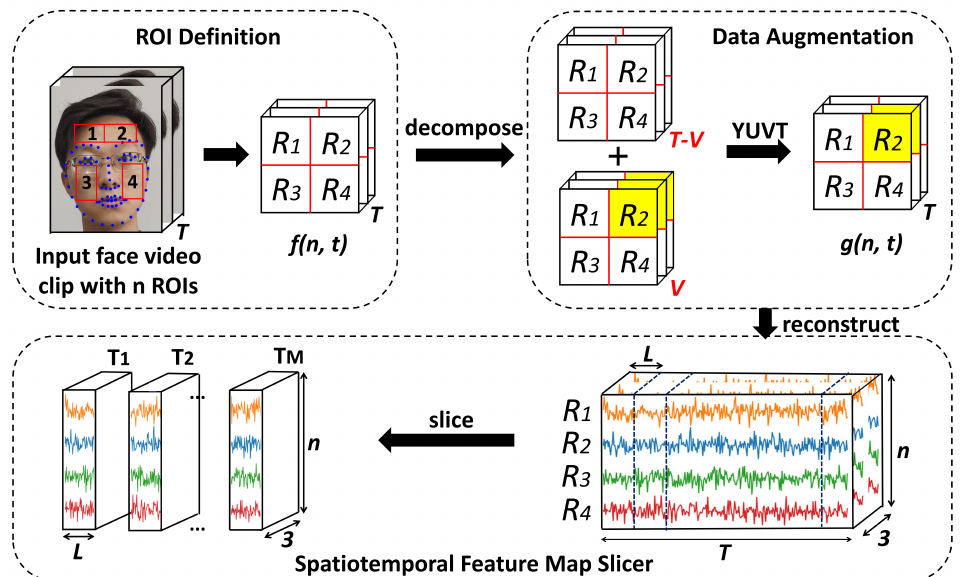
Figure 2. An illustration of the generation of spatiotemporal feature map slices from an input facial video clip of T frames. Firstly, we use Seetaface6 to detect the human face, localize 68 landmarks, and define four ROIs; then, we calculate the average pixel values of each ROI to get spatiotemporal maps. Secondly, the data augmentation module randomly masks a part of the cropped spatiotemporal maps presented above along both the time domain and the spatial domain; then, they are transformed from the RGB color space into the modified YUV color space. Finally, the cropped video sequence is sliced to generate the spatiotemporal feature map slices for the following